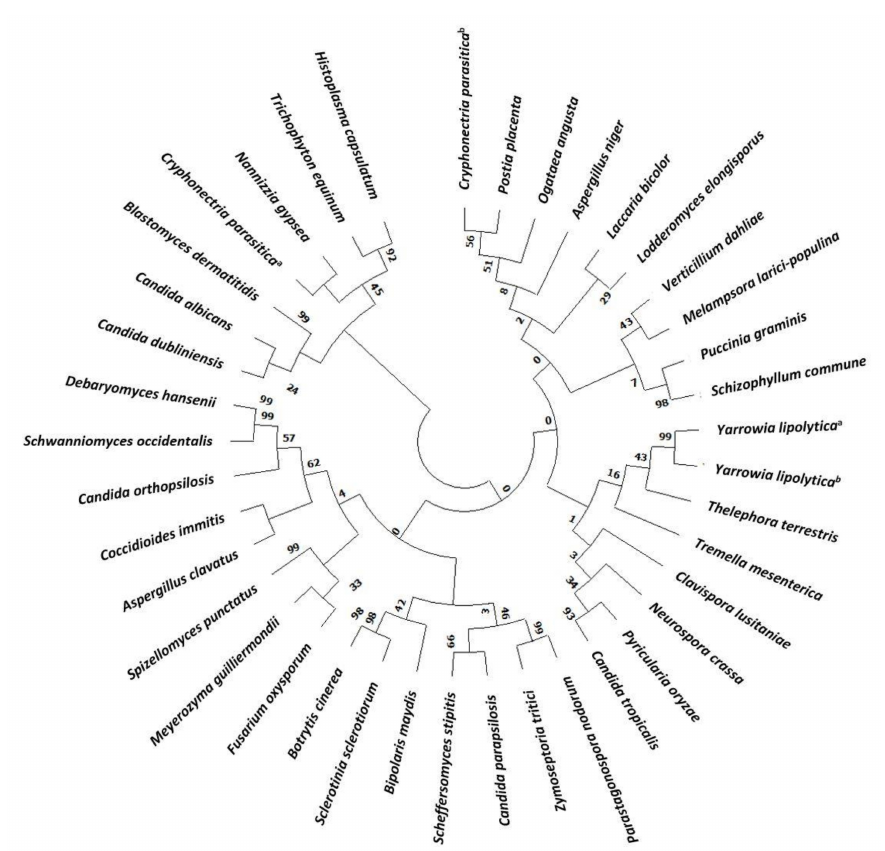
Figure 1. Phylogenetic tree of Hak family proteins in main fungi. Databases used for identification were: National Center for Biotechnology Information (NCBI) and Joint Genome Institute